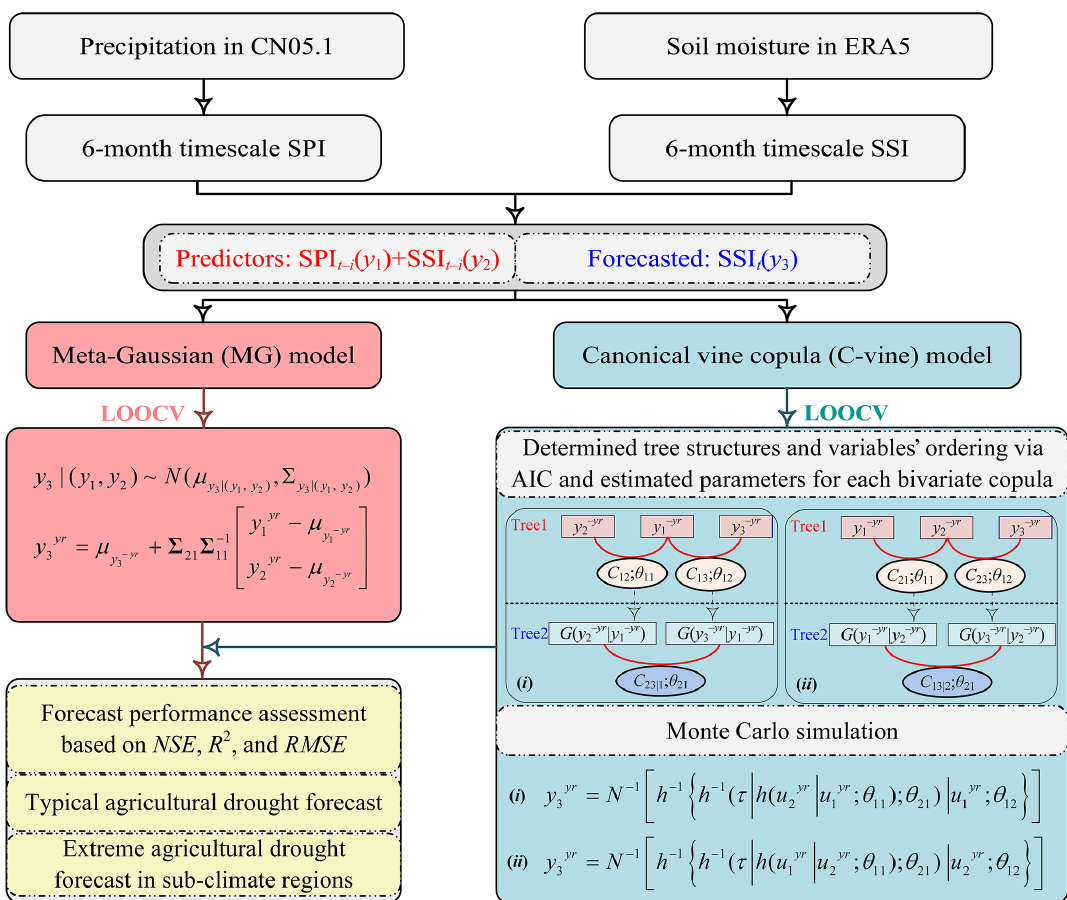
Figure 3. Flowchart of agricultural drought forecasting based on the canonical vine copulas (3C-vine) and meta-Gaussian (MG) models using three-dimensional scenarios. Here, t denotes the target month (e.g., August), i signifies the lead times (1–3 months), LOOCV stands − yr − yr (y ) indicates the series after removing a sample ( y yr for leave-one-out cross-validation, y 1 2 agricultural drought forecast value for the target month of a specific year. Note that the optimal tree structure (i or ii on the right-hand side of this figure) is selected based on the AIC to forecast agricultural